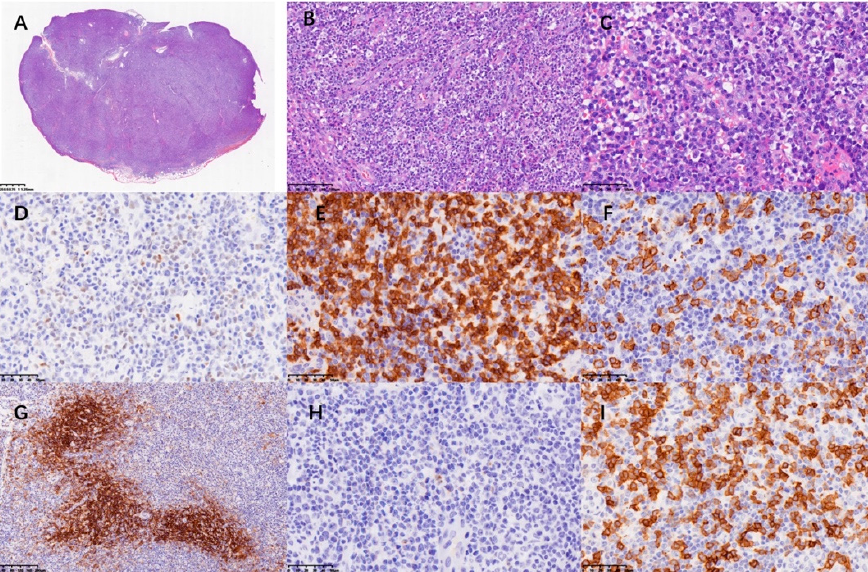
Figure 4. ( A – C ) Biopsy of left cervical lymph node showed effacement of architecture and diffuse hyperplasia of medium-large-sized heterogenous lymphocytes with oval nuclei and clear or faintly eosinophilic cytoplasm. The hyperplasia of HEV and plasma cells and infiltrates of eosinophils were also observed. The neoplastic cells were positive for Bcl-6 ( D ), CD3 ( E ) and PD-1 ( I ) in IHC. CD20 ( F ) stood for B cells and CD21 ( G ) labeled follicular dendritic cell meshwork. CXCL13 ( H ) was negative. Finally, he was diagnosed with AITL and was treated with VP16, dexamethasone and lenalidomide. Unfortunately, this patient died of septic shock and respiratory failure caused by pneumonia two months after diagnosis.